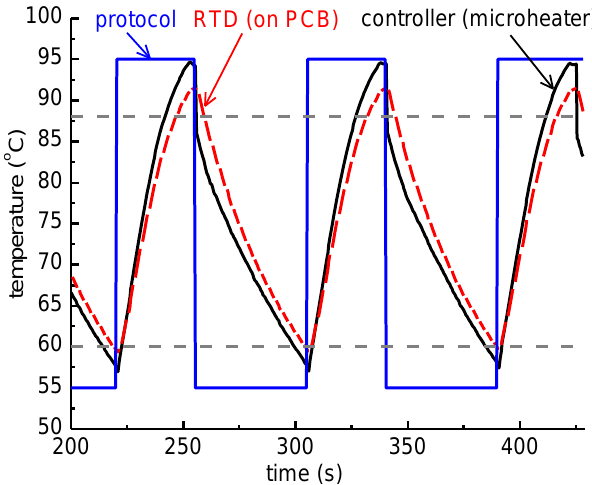
Figure 8. Graphical representation of the temperature measured while running an actual 2T thermocycling experiment with a thin PCB microheater chip. The protocol followed by the temperature controller was 35 s at 95 ◦ C followed by 50 s at 55 ◦ C (blue line). The temperature of the microheaters as obtained from their resistance values acquired by the temperature controller, and the temperature measurement from the RTD placed on the copper layer (see Figure 1) of the microPCR, are also shown. Finally, dashed lines correspond to 88 ◦ C and 60 ◦ C accordingly.